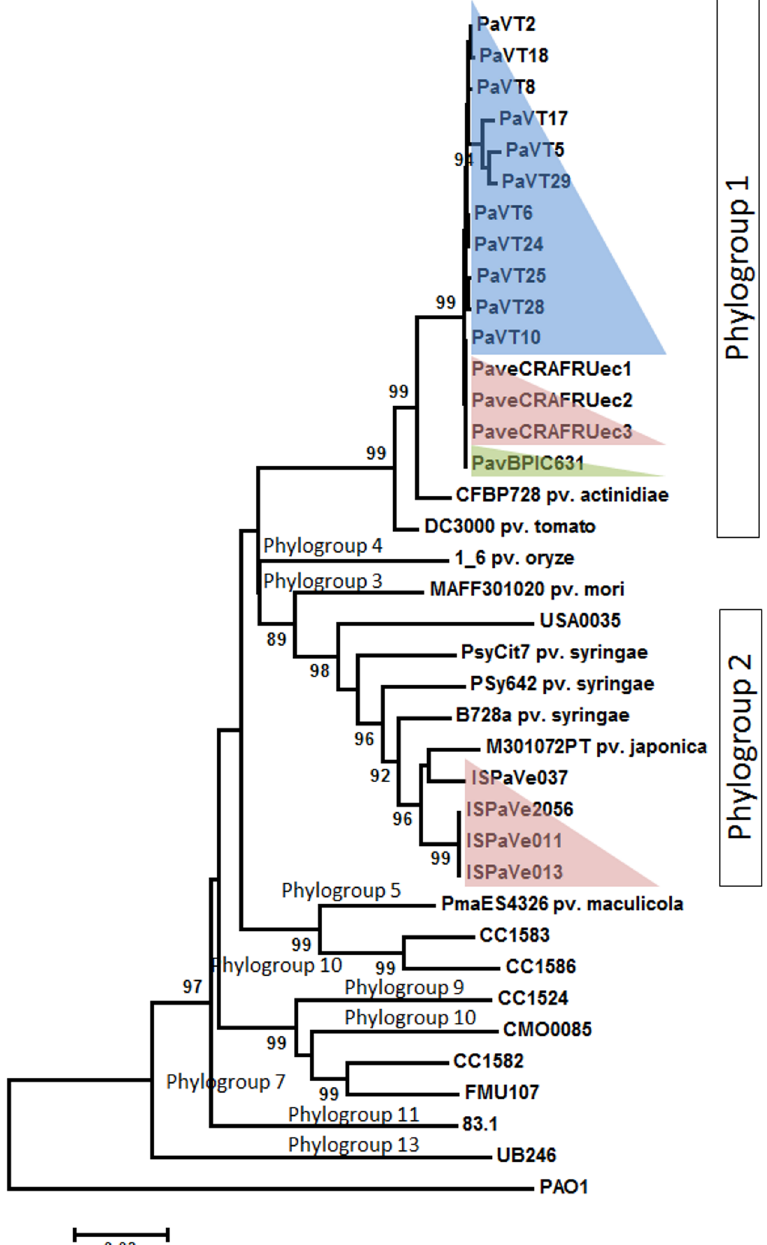
Fig 5. Bayesian tree constructed on the concatenated sequences of cts , gyrB , rpoD and gapA (1465bp). Bootstrap values are indicated at each node, while names at the branches indicate the name of the strains. Pathovar affiliations are reported for some of the Pseudomonas syringae strains belonging to different phylogenetic groups. Sequences for the different P . syringae strains and their phylogroup affiliation were described previously by Berge et al. [46]. MLST sequences of the Pav strains isolated previously from Greece and Italy were reported by Wang et al. [18]. Sequences for PavCRAFRUec1, PavCRAFRUec2 and PavCRAFRUec3 are published by Marcelletti and Scortichini [41]. Pseudomonas aeruginona (PAO1) was used as an outgroup. Triangles with different colours are used to label strains in the following way. Blue triangles: strains isolated in this study, red triangles: strains isolated in central Italy during the first epidemic, and green triangles: strains isolated in Greece.